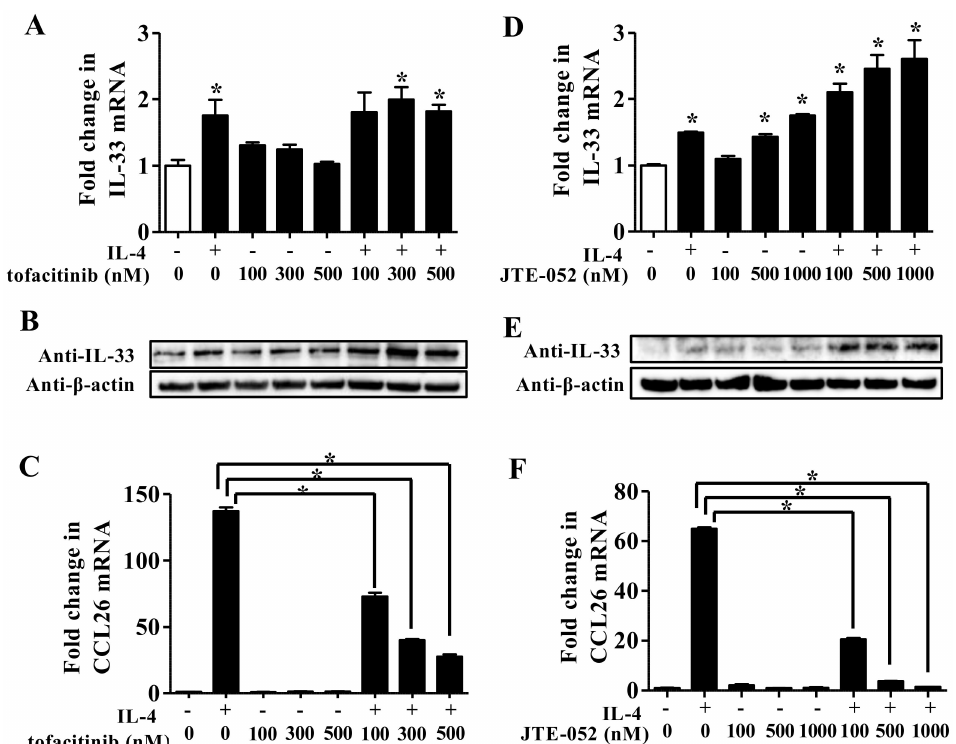
Figure 2. ( A – F ) NHEKs were treated with IL-4 (10 ng / mL) in the presence or absence of either tofacitinib (100, 300, and 500 nM) or JTE-052 (100, 500, and 1000 nM) for 24 h. ( A , D ) IL-33 mRNA expression was analyzed by qRT-PCR. ( B , E ) IL-33 protein expression was analyzed by Western blotting with an anti-IL-33 antibody. The data are representative of experiments repeated three times with similar results. ( C , F ) mRNA of CCL26 in NHEKs treated with IL-4 (10 ng / mL) in the presence or absence of either tofacitinib (100, 300, and 500 nM) or JTE-052 (100, 500, and 1000 nM) for 24 h was analyzed by qRT-PCR. ( A , C , D , F ) Data are expressed as mean ± S.E.M.; n = 3 for each group. ( A , D ) Statistically significant di ff erences between the expression of control and treated NHEKs are presented: * p < 0.05 ( A , D ). * p < 0.05 ( C , F